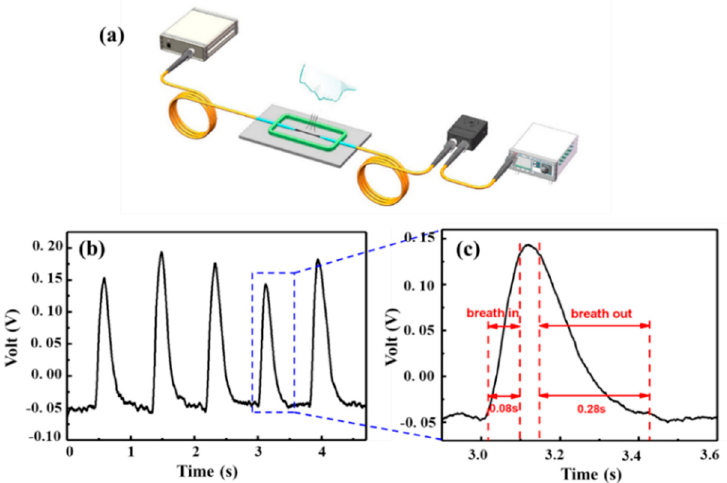
Figure 10. ( a ) Experimental setup for monitoring human breath. ( b ) Response characteristic of human breath with five cycles. ( c ) Enlarged view of the response from the fourth cycle to evaluate the response time and recovery time.